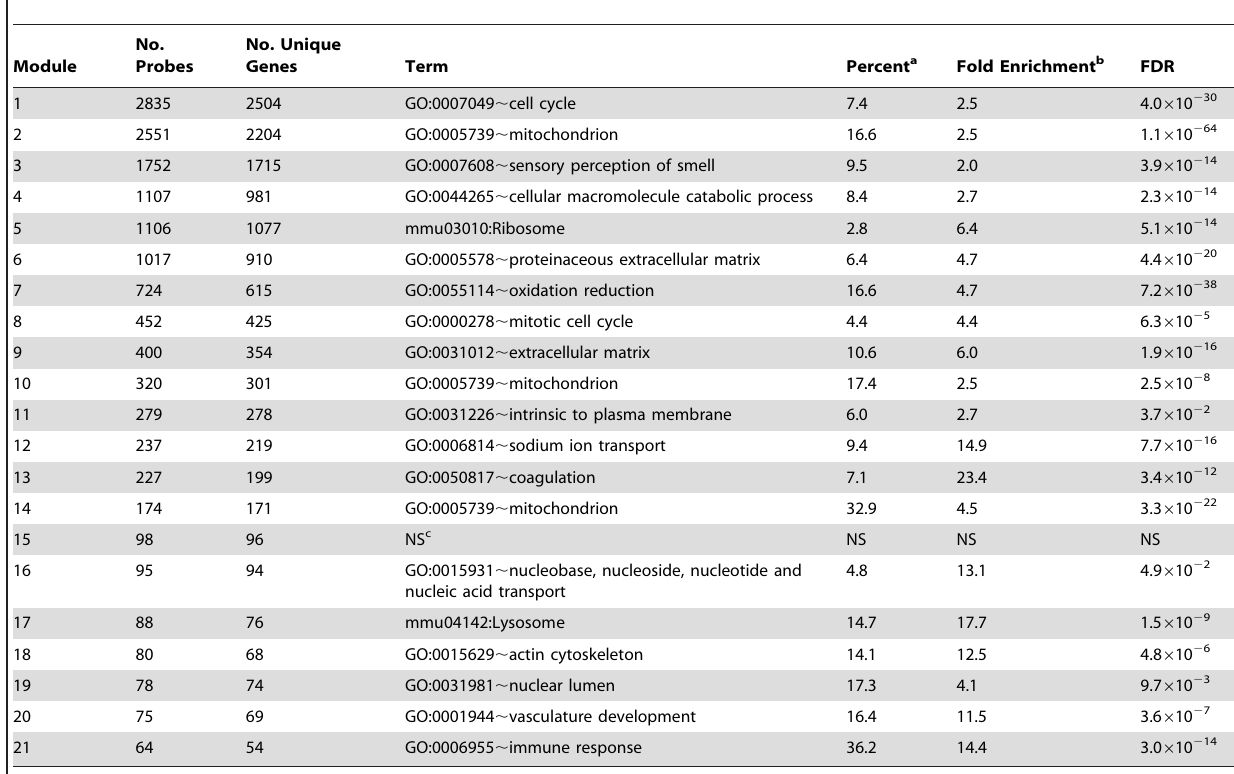
Table 1. Number of genes and most significant functional enrichment for each of the 21 bone network modules.